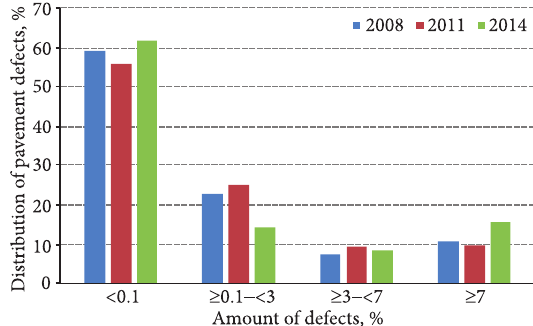
Fig. 5. Distribution of pavement defects in main roads of Lithuania